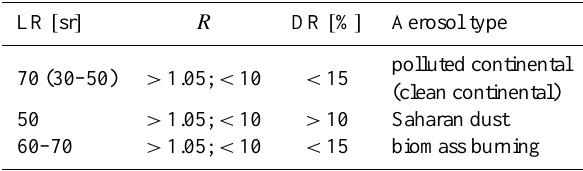
Table 1. List of lidar ratios (LR) selected as a function of backscat- ter ratio ( R ) and depolarization ratio (DR). For polluted continental air masses, different values were tentatively employed for a sensi- tivity